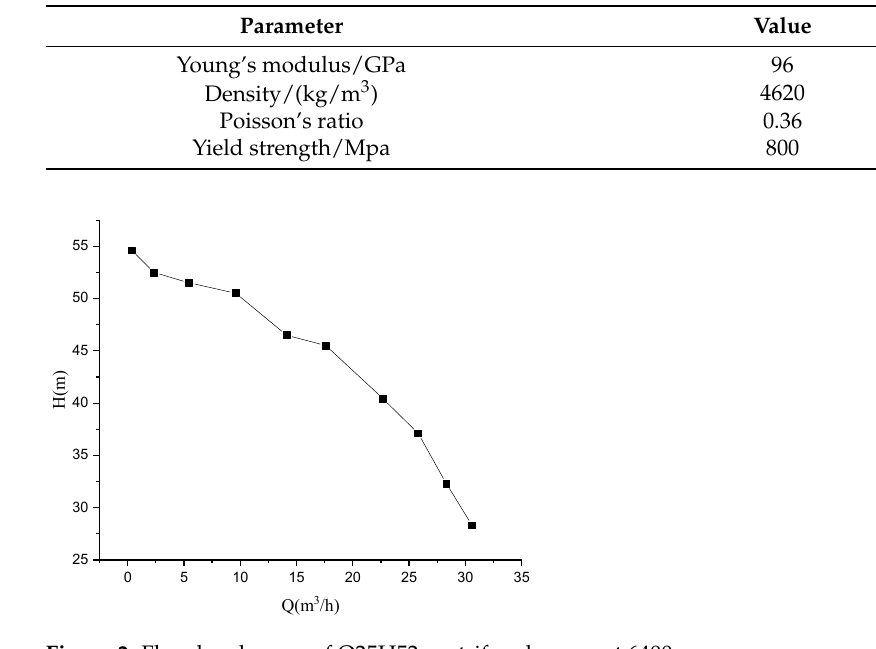
Table 1. Impeller material performance parameters.